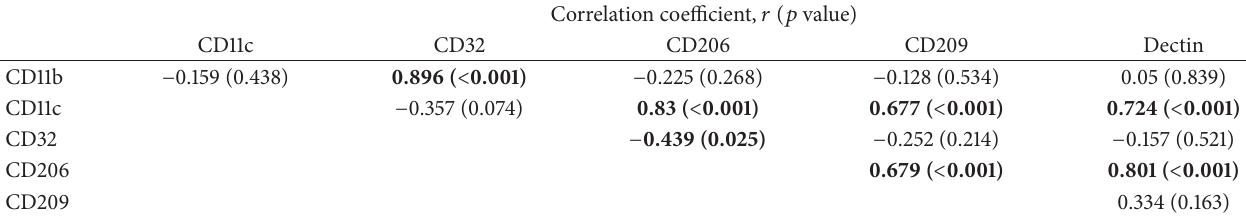
Table 5: Correlations between each pattern recognition marker in whole leukocytes of patients with Behc¸et’s